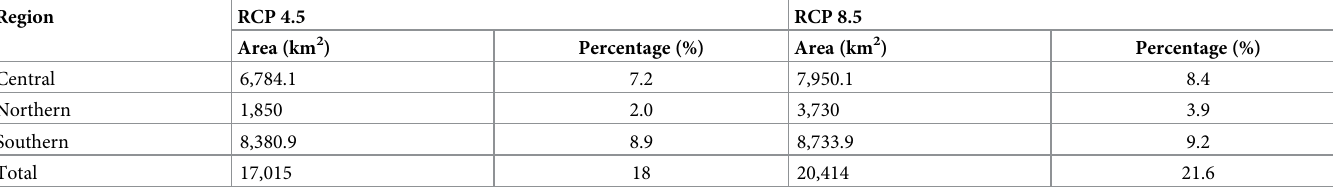
Table 4. Simulated impacts of climate change on macadamia suitability in Malawi.